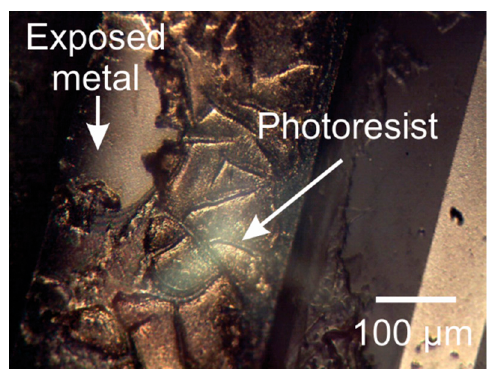
Figure 18. Oxygen plasma treated AZ P4620 photoresist residue on metal feature.